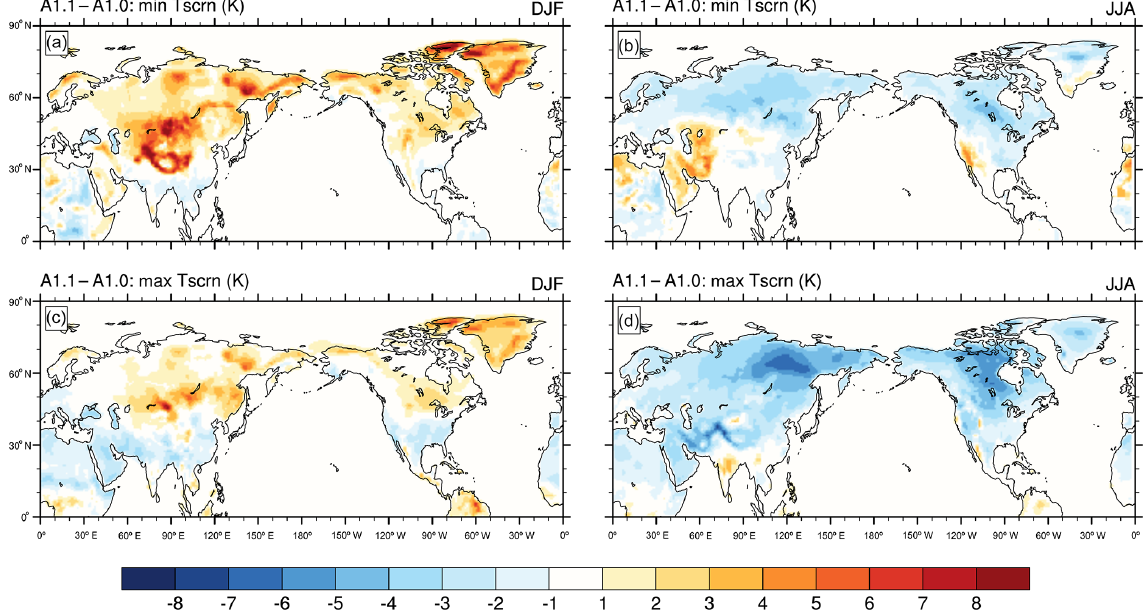
Figure 6. Northern Hemisphere seasonal minimum and maximum screen temperature (K) difference between ACCESS1.1 and ACCESS1.0 for DJF and